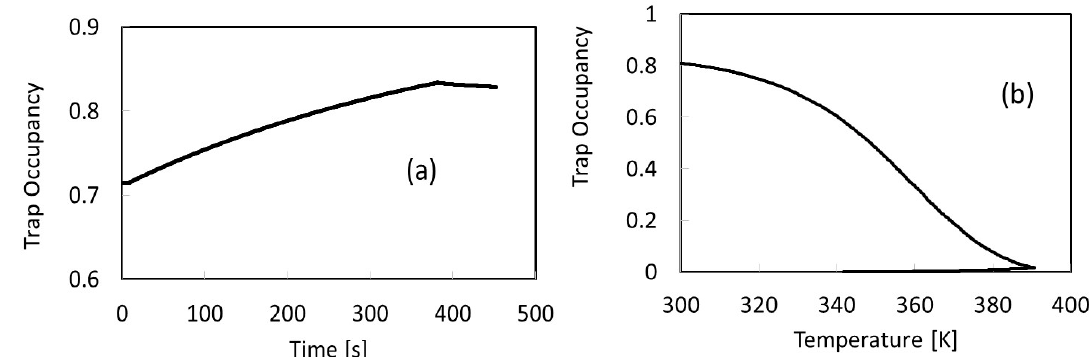
Figure 7. Trap occupancy of the energy level E t = 0.45 eV during ( a ) the photoconductivity measurement shown in Figure 6, and ( b ) the TSC measurement shown in Figure 2 and Figure 4.